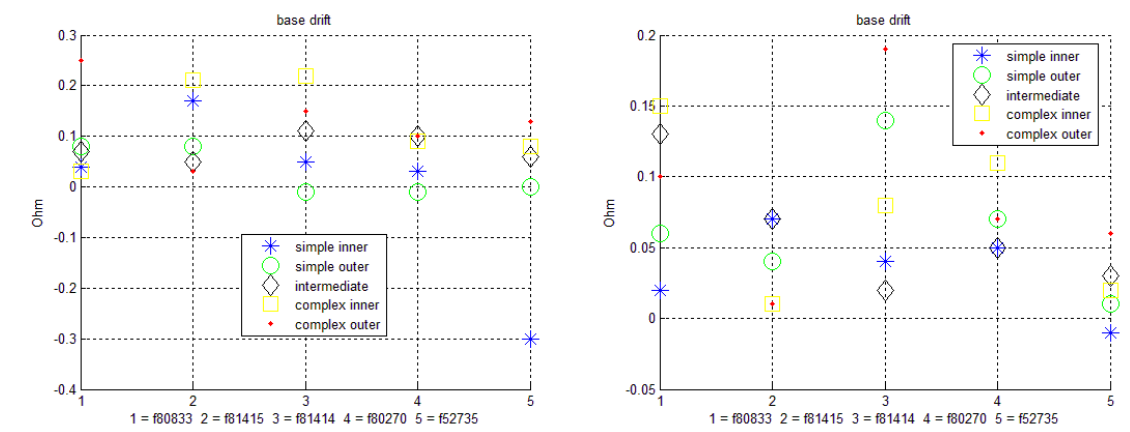
Figure 13. Base drift: ( left ) un-insulated case; ( right ) insulated